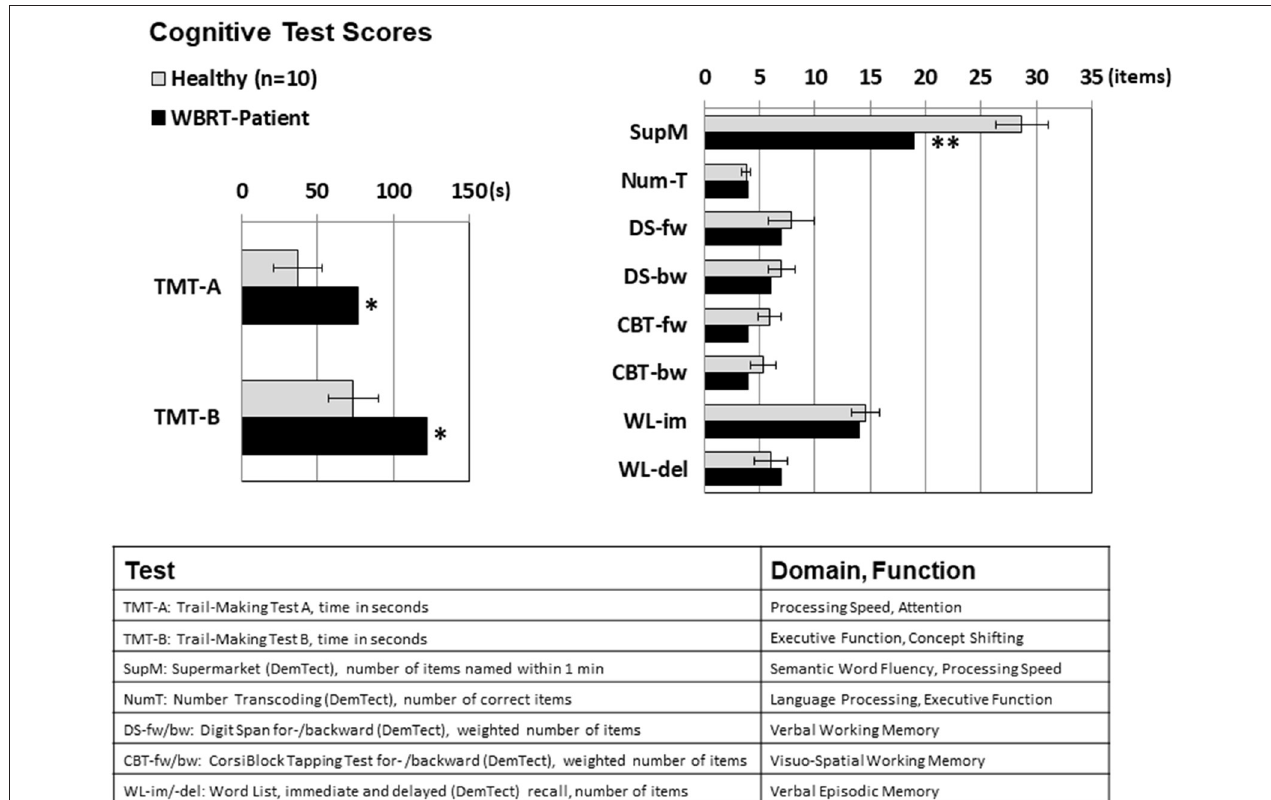
FIGURE 2 | Cognitive test scores for Trail Making Tests A and B (measured in seconds, lower numbers mean better results) and for the tests scored by the number of items achieved (higher scores mean better results). Significant performance differences between the WBRT patient and the healthy subjects were observed for cognitive domains with a component of executive functioning (TMT-A: attention/ processing speed, TMT-B: executive function/concept shifting, supermarket test: semantic word fluency), while the scores for the memory domains were not significantly lowered. For the healthy subjects, means ± standard deviations are depicted; * p < 0.05, ** p < 0.01, one-sample t